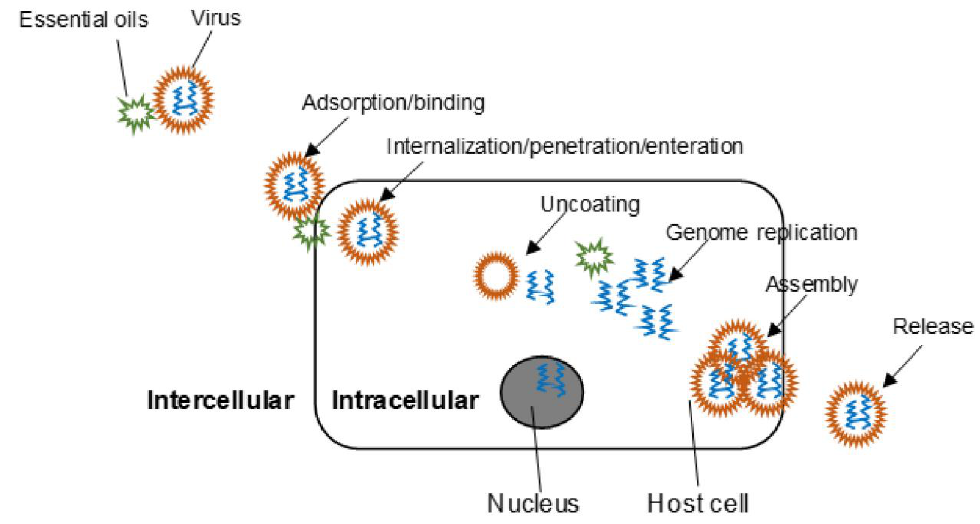
Figure 5. Potential target sites for essential oils to exhibit antiviral action. Adapted with permission from ref. [68], published by MDPI, 2020.